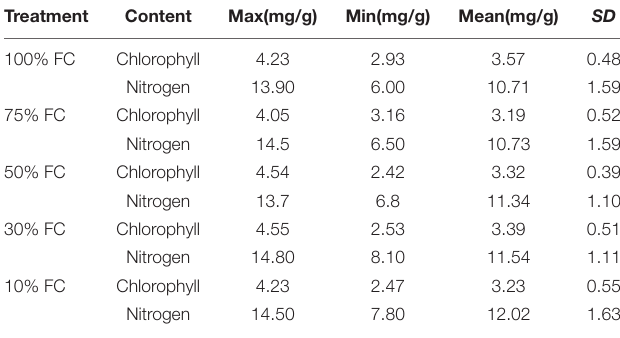
TABLE 2 | Statistics of chlorophyll and nitrogen content of T. sinensis seedling leaves with different water